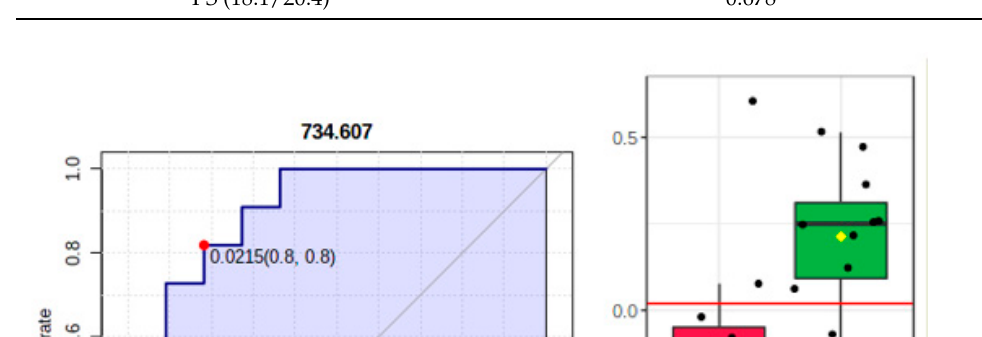
Table 4 mentions the identification of molecules and the VIP, p - and fold change (FC)